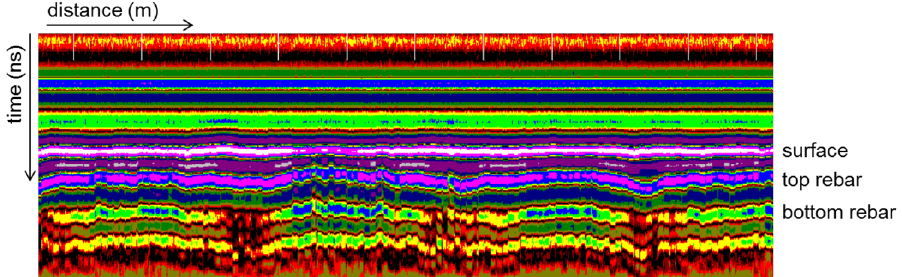
Fig. 3 Typical GPR B-scan image of a section of a RC deck measured by an air-coupled